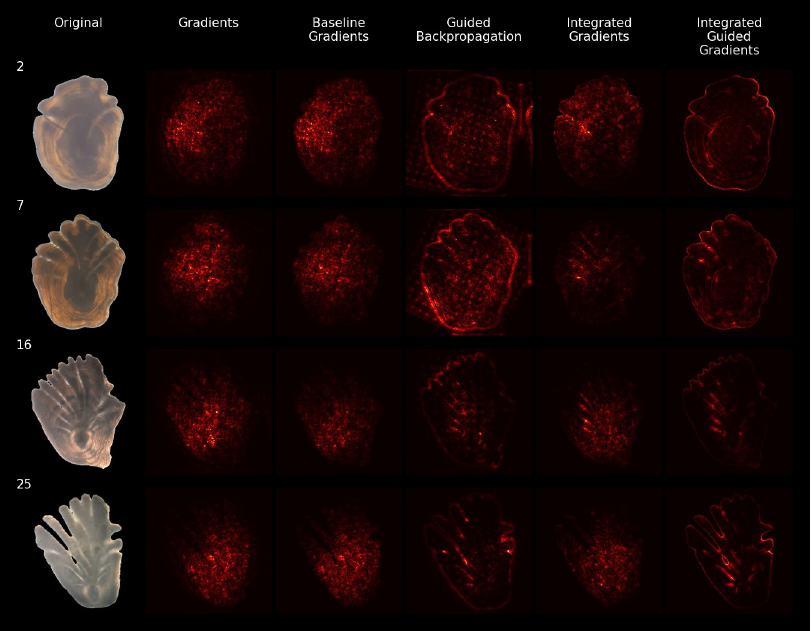
Fig 10. Comparison of explainability methods. Heatmaps produced by five different techniques, for a selection of otolith images from different age groups.